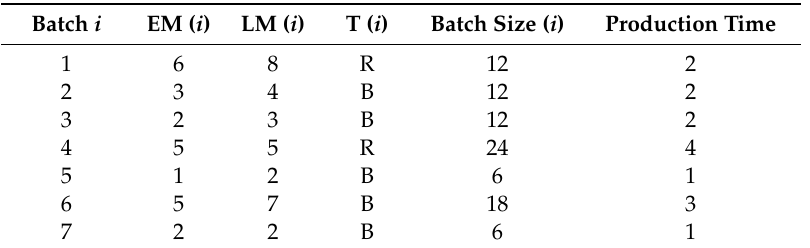
Table 1. Data for operated